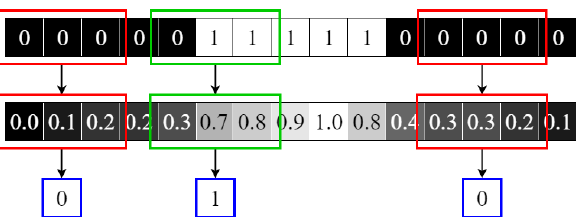
Figure 4. Example of gathering fixed-length one-dimensional patches with their labels.